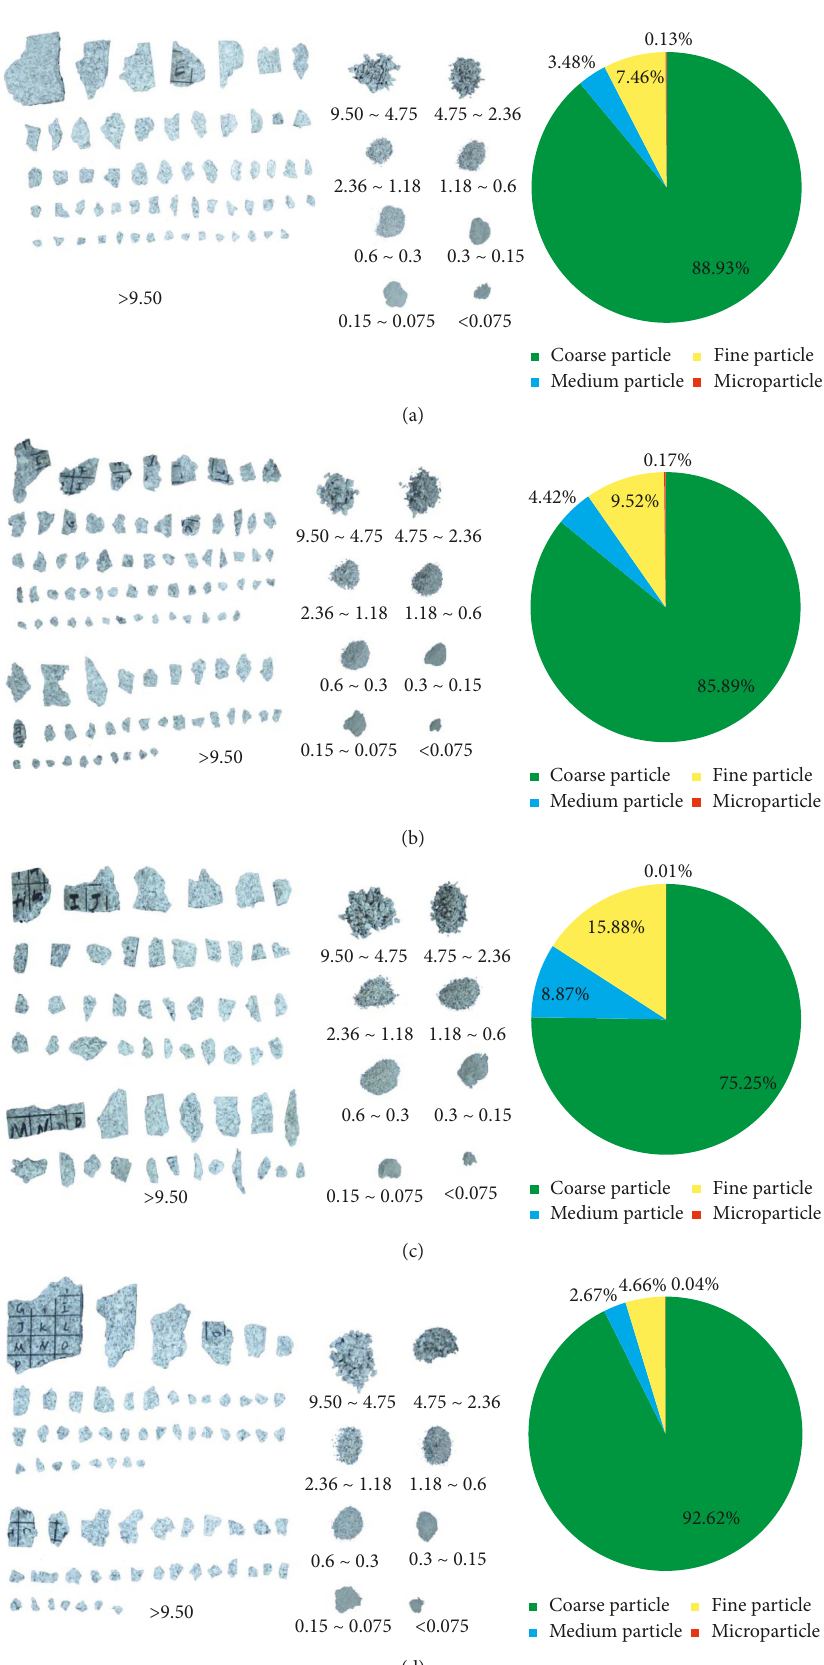
0.1 MPa/s; (b) v 0.5MPa/s; (cid:31) (cid:31)